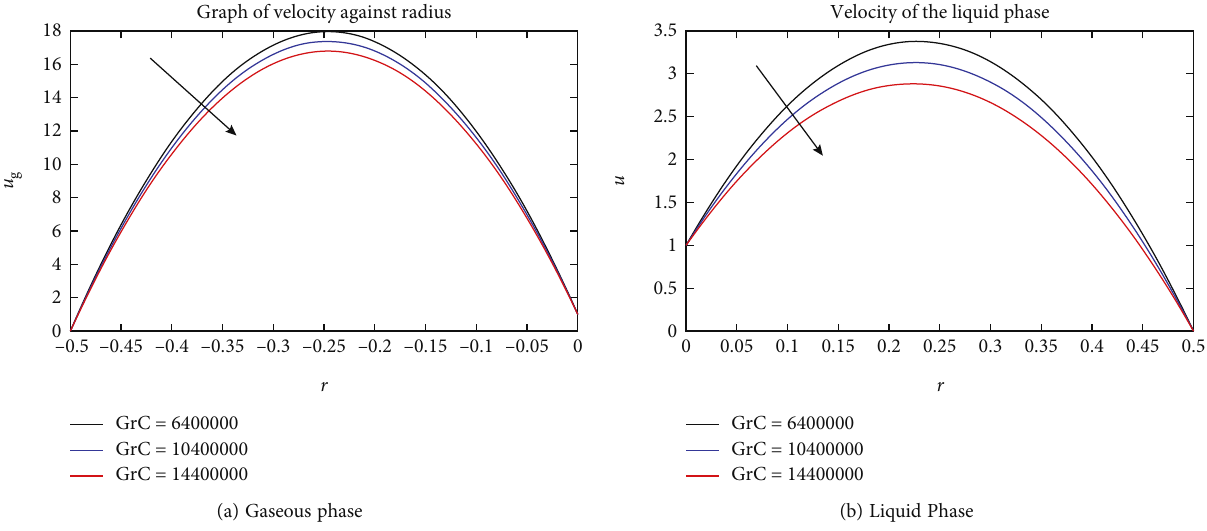
Figure 3: E ff ect of Grashof Solutal Number on